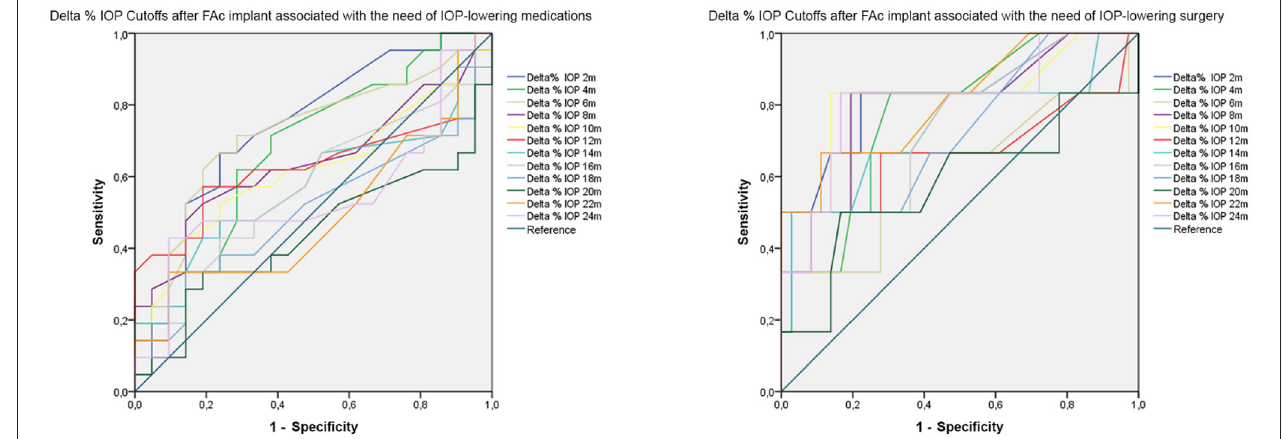
FIGURE 1 | ROC analysis of Delta% IOP cutoffs associated with the need of IOP-lowering medications or IOP-lowering surgery after FAc